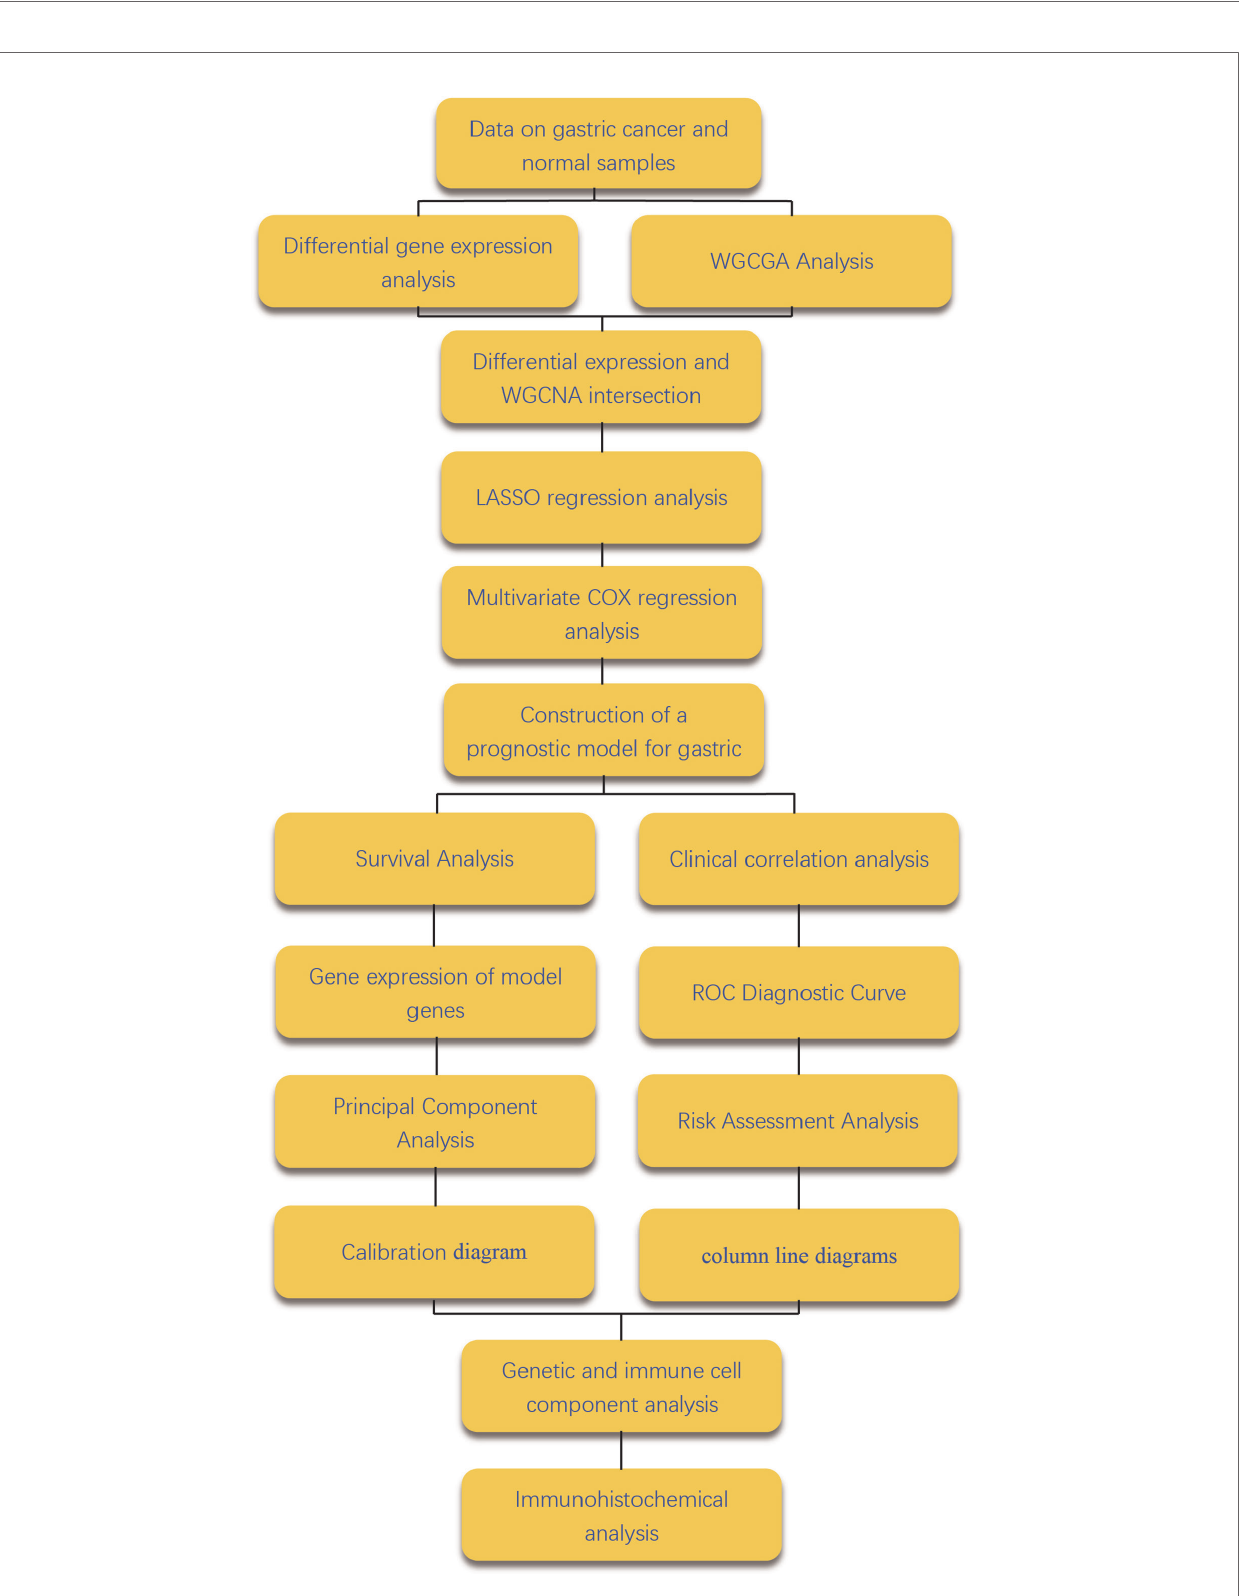
Frontiers in Oncology |